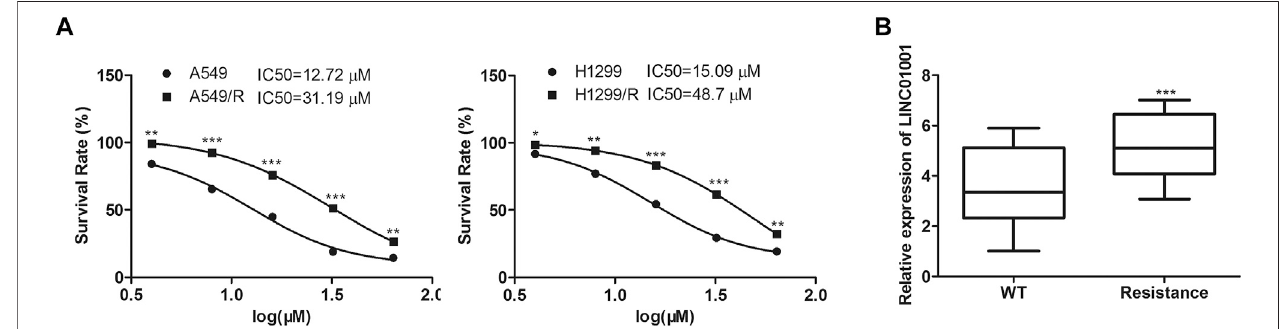
FIGURE 1 | LINC01001 is highly expressed and associated with poor overall survival of NSCLC patients. (A) Evaluating the IC50 of crizotinib in NSCLC cells. *p < 0.05, **p < 0.01, ***p < 0.001 vs A549/H1299 group. (B) LINC01001 is highly expressed in crizotinib-resistant NSCLC cells. *** p < 0.001 vs WT group. Error bars represent SD. Data represent three independent experiments.